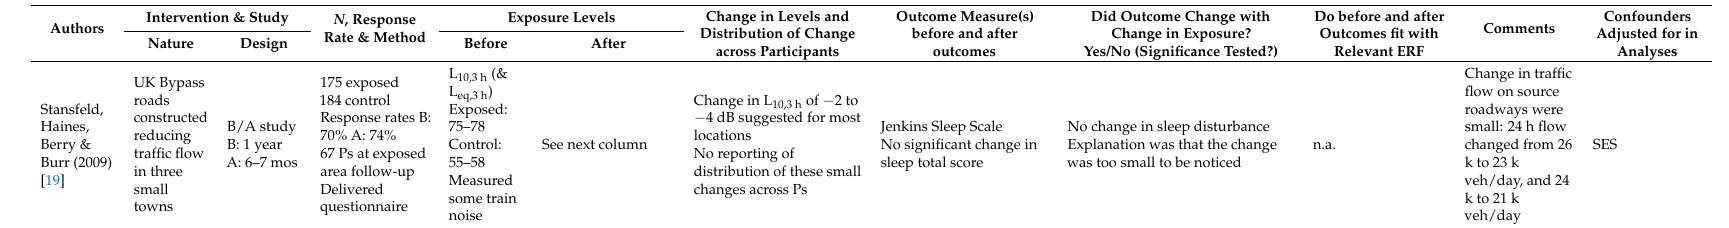
Table 7. Source Interventions (Type A).